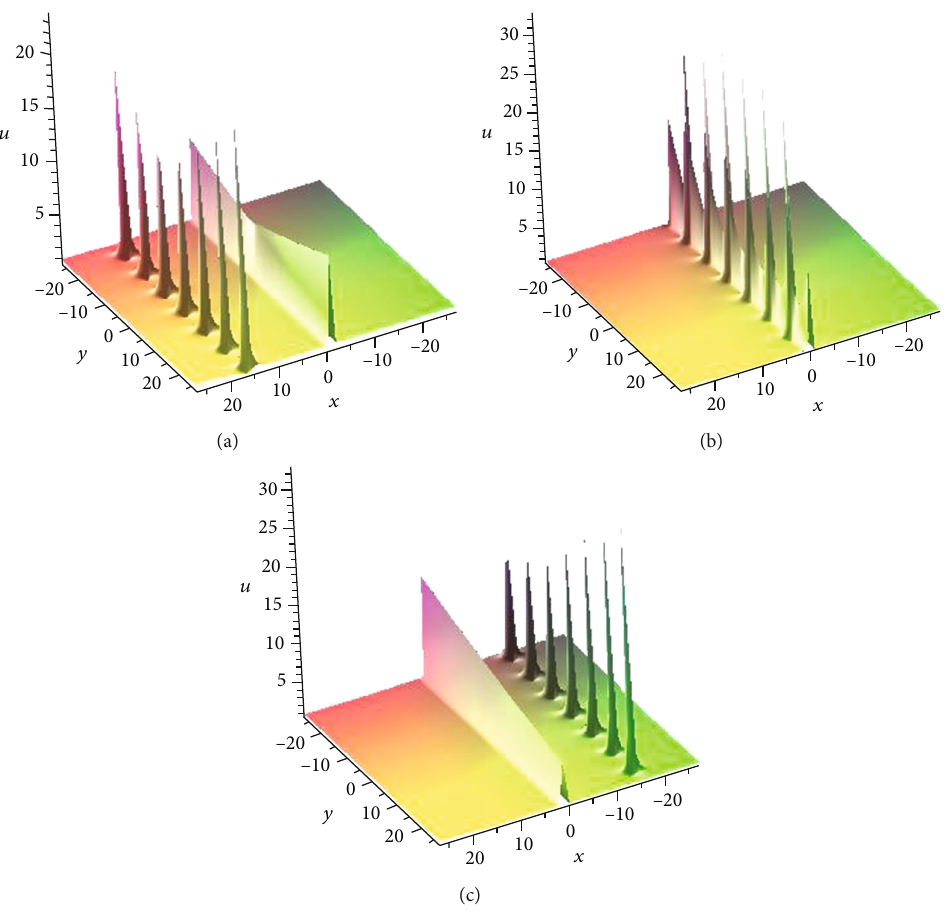
= − 10 , β 0 = − 10 , and β 0 = 10 . (b) Breather-soliton molecule in β 0 1 2 3